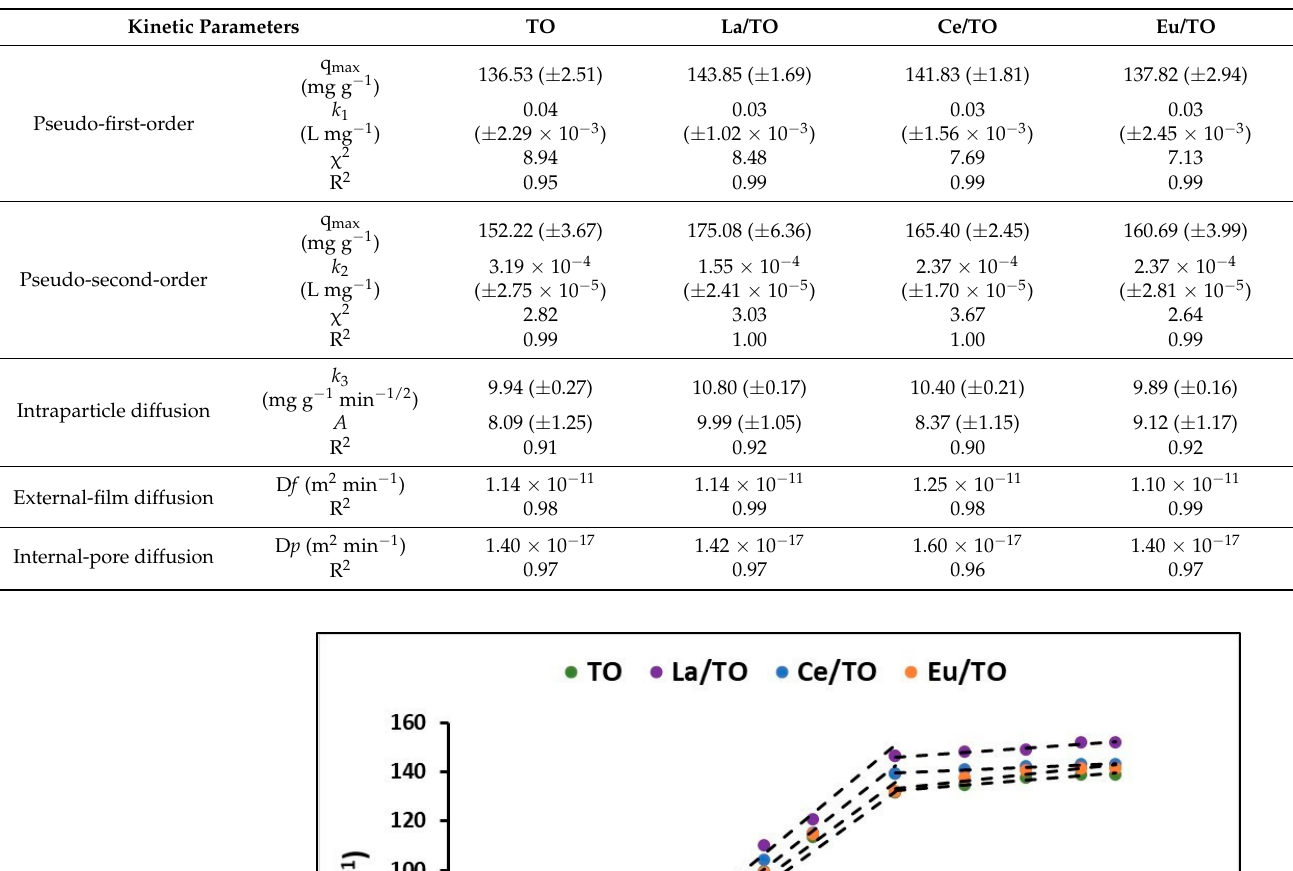
Table 4. Kinetic parameters for cyanide sorption on nanoparticles. Kinetic Parameters